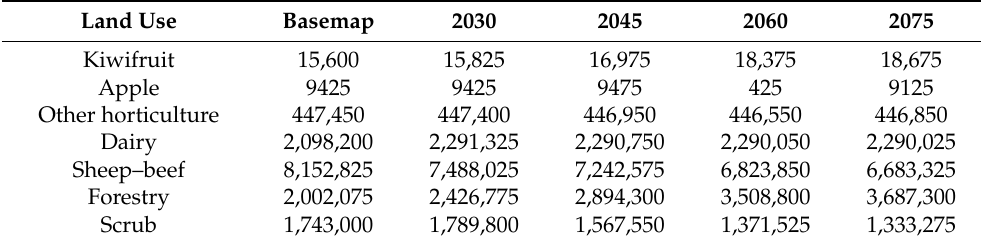
Table 3. Simulated land use (hectares) with severe climate change Representative Concentration Pathway (RCP)